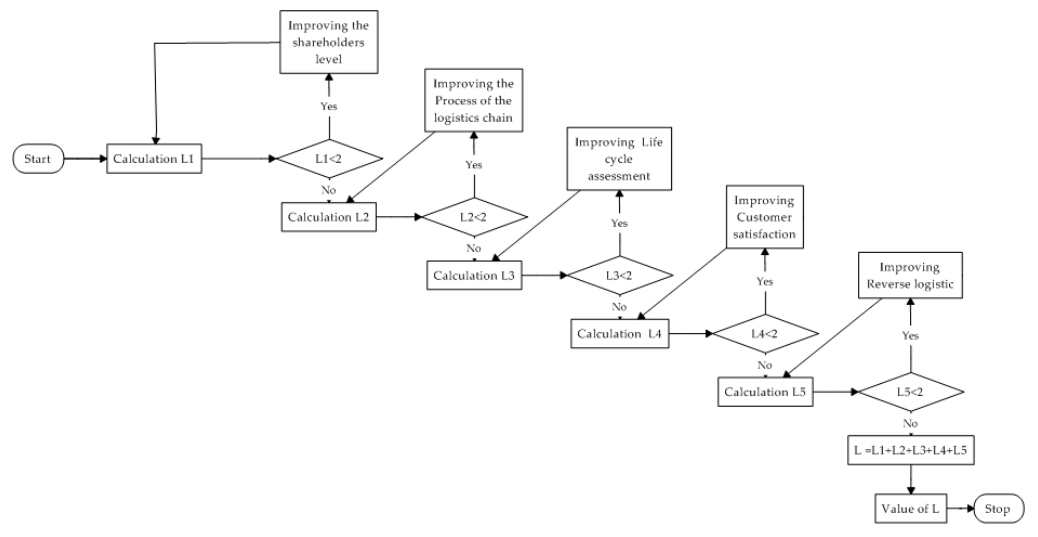
Figure 7. Empirical evaluation based on the proposed hierarchical framework.